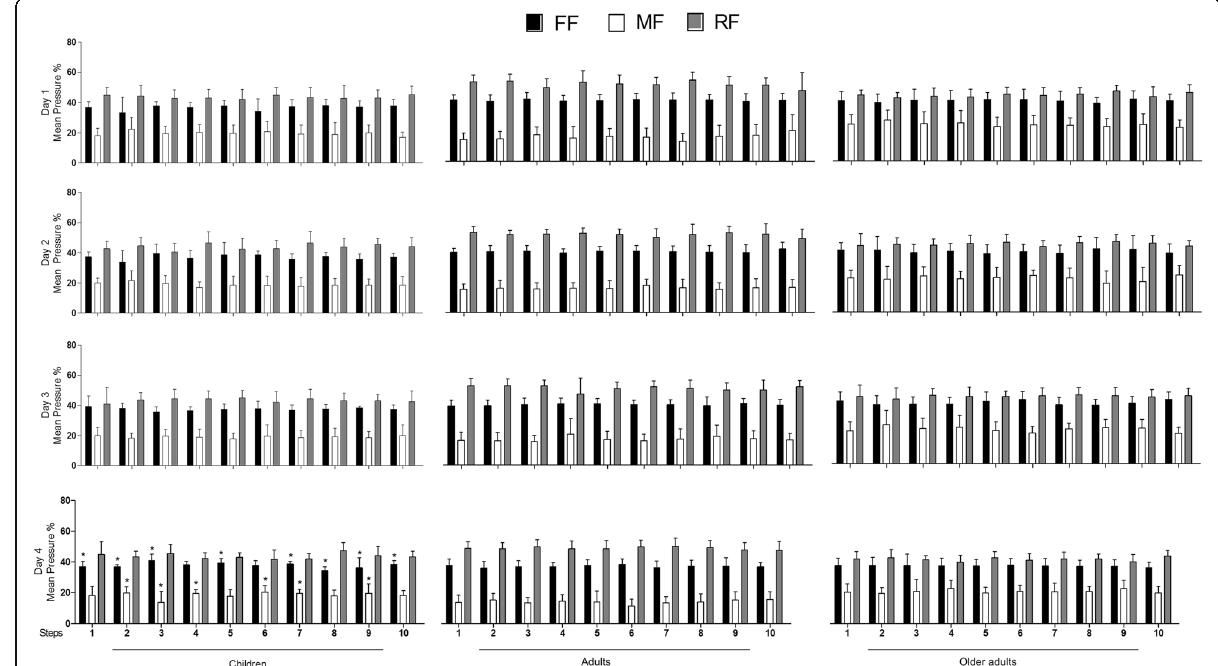
Fig. 2 Mean pressure determined in different foot regions and expressed as a percentage of total foot pressure. Data are presented for each step and group in the four days of measurement. * indicates difference between the